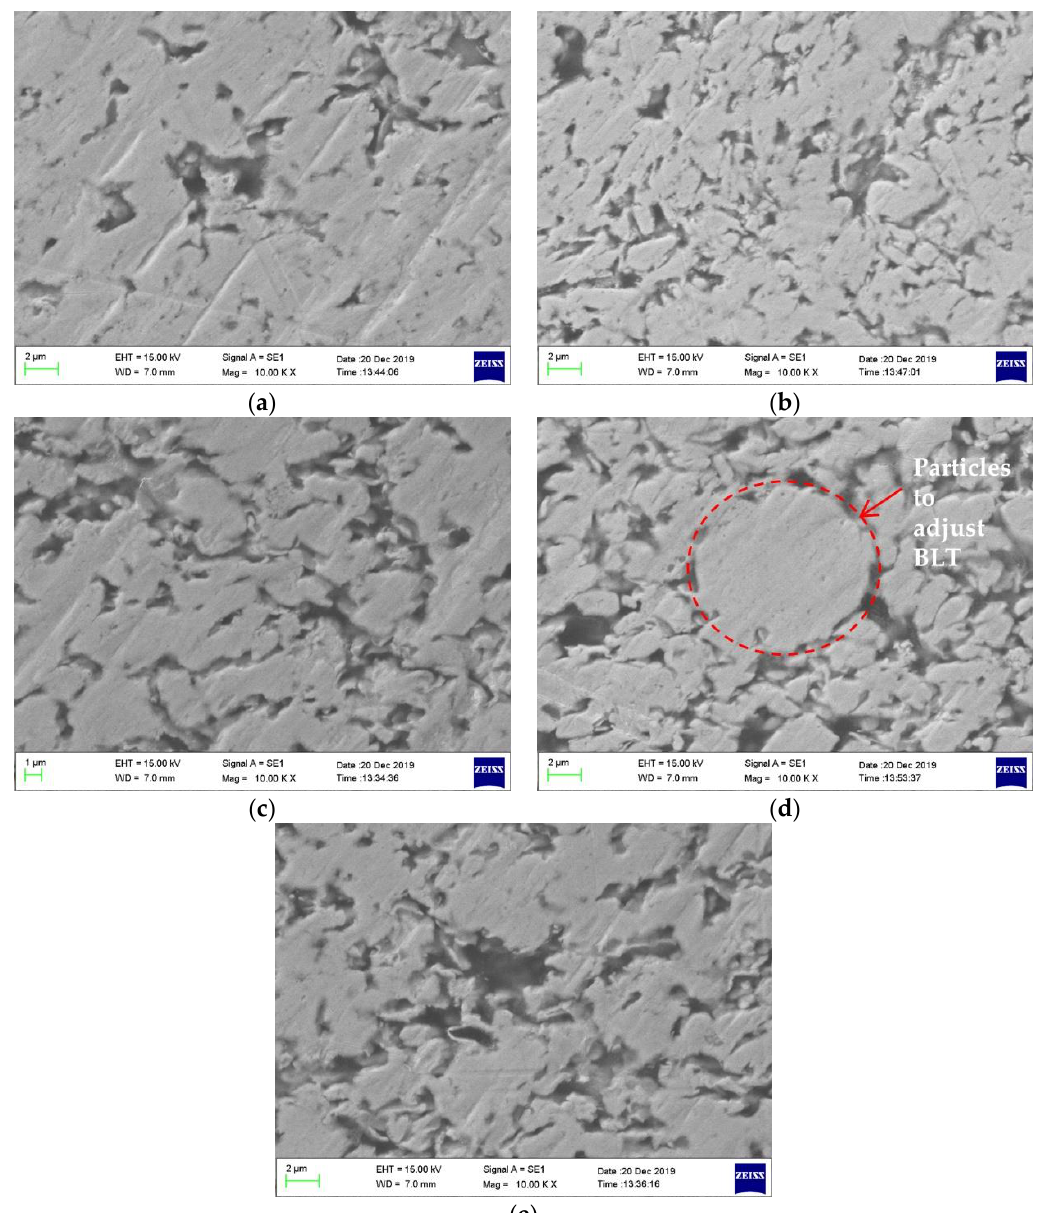
Figure 5. SEM images of micron silver sintered joints under thermal shocks for: ( a ) 0; ( b ) 50; ( c ) 100; ( d ) 150; and ( e ) 250 cycles.